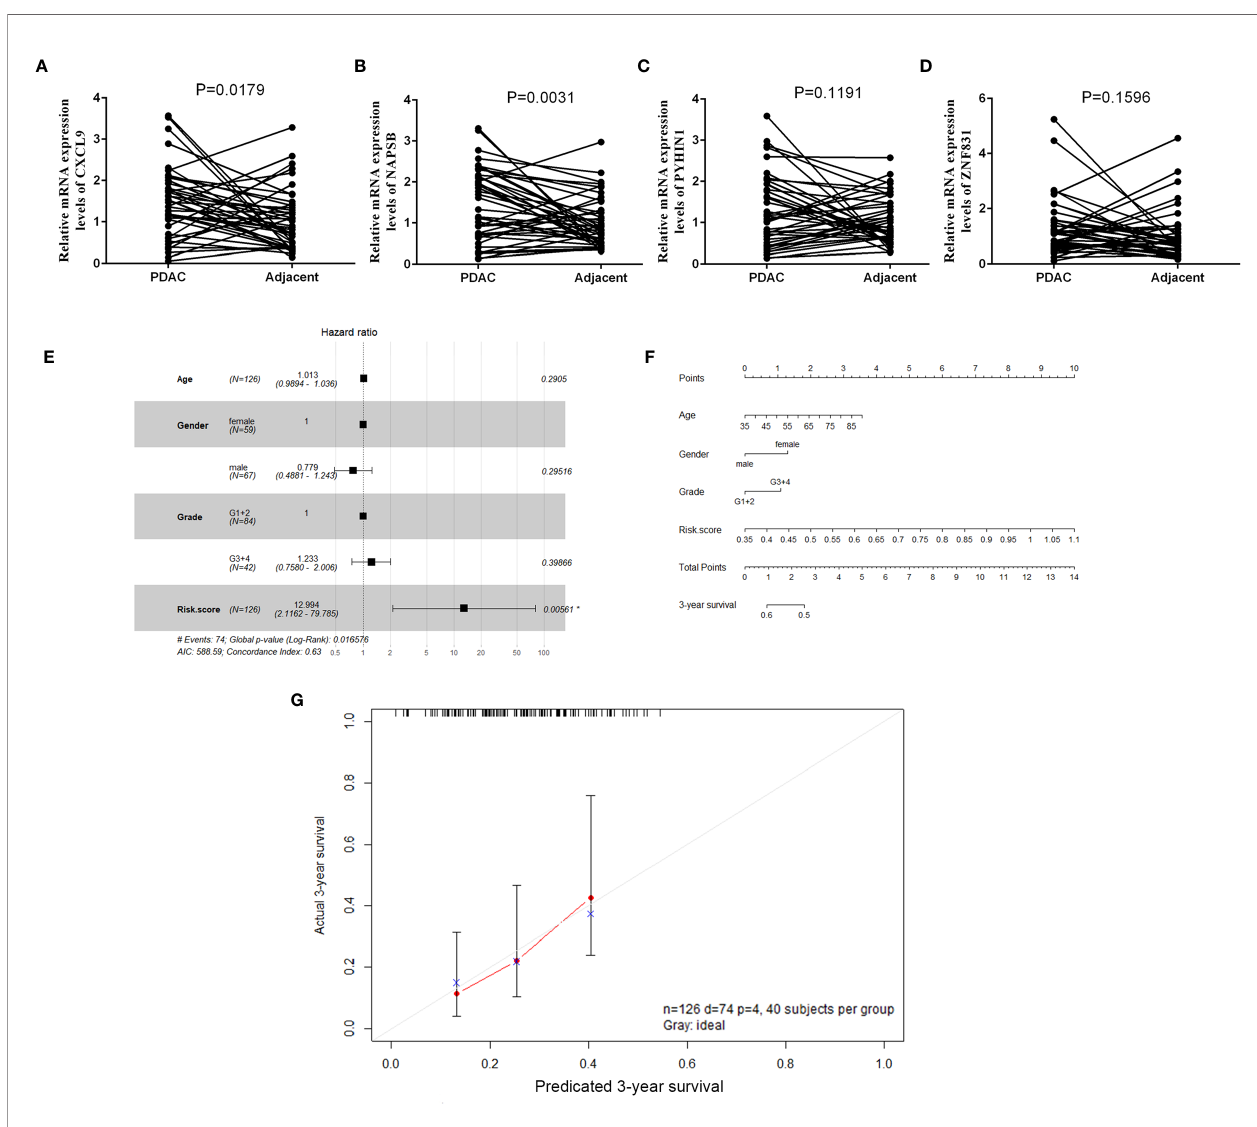
FIGURE 7 | The expression and clinical signi fi cance of gene signature in PDAC. (A – D) Expression of four genes in tumor and adjacent normal tissues from a cohort of 42 PDAC patients was determined by qPCR. (E) Forest plot summary of multivariable Cox regression analyses of the risk score, age, gender and grade on TCGA cohort. The squares represent the hazard ratio (HR), and the transverse lines represent 95% CI. CI, con fi dence interval. (F) A nomogram to predict survival probability at 3-year for PDAC patients based on the results deriving from the TCGA cohort. (G) Calibration curve for the nomogram when predicting 3-year overall